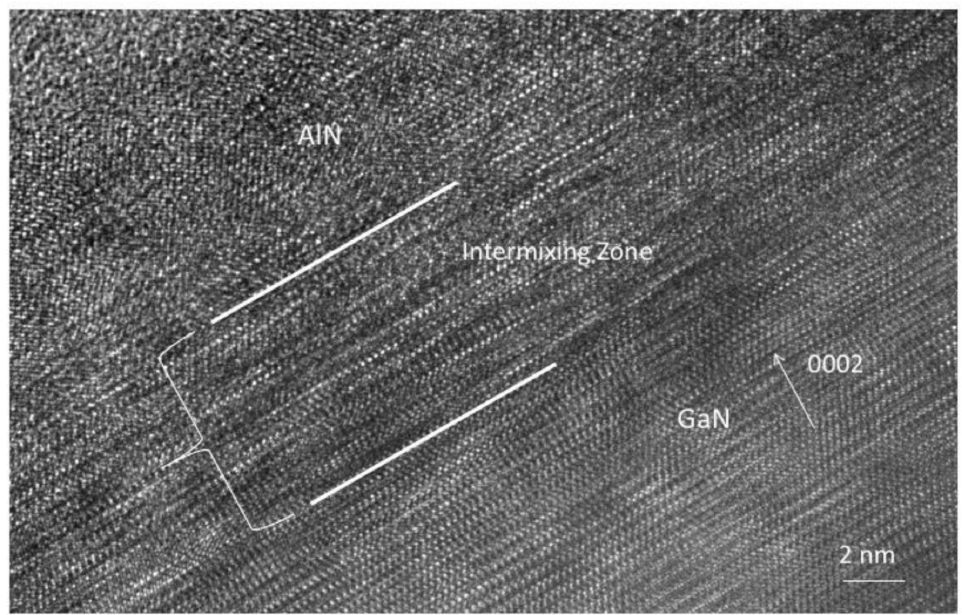
Figure 7. HRTEM showing the intermixing at the AlN/GaN interface. The interface layer is approxi- mately 6 to 8 nm